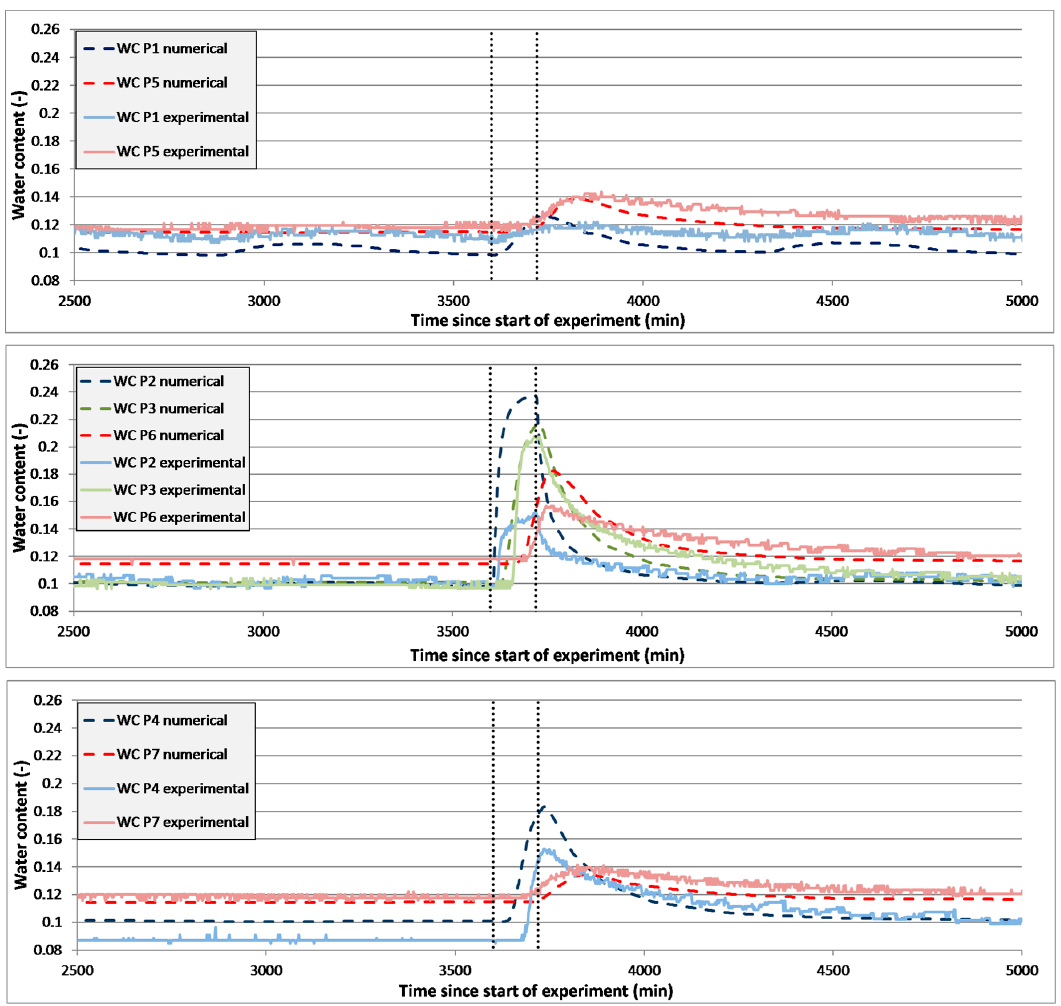
Figure 3. Results for water content simulation for scenario WW-RE-Rep-1 (sep.) as compared to observed values in the laboratory tank experiment for the time 2500 to 5000 min. after onset of the numerical experiment, black dotted line indicates duration of precipitation event.